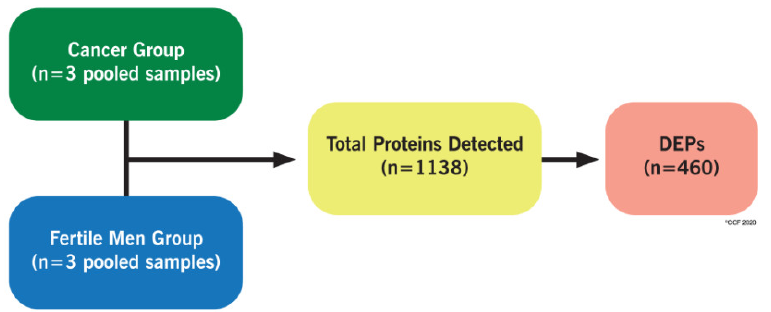
Figure 1. Proteome profile of sperm in cancer group and fertile men. DEPs: differentially expressed proteins.